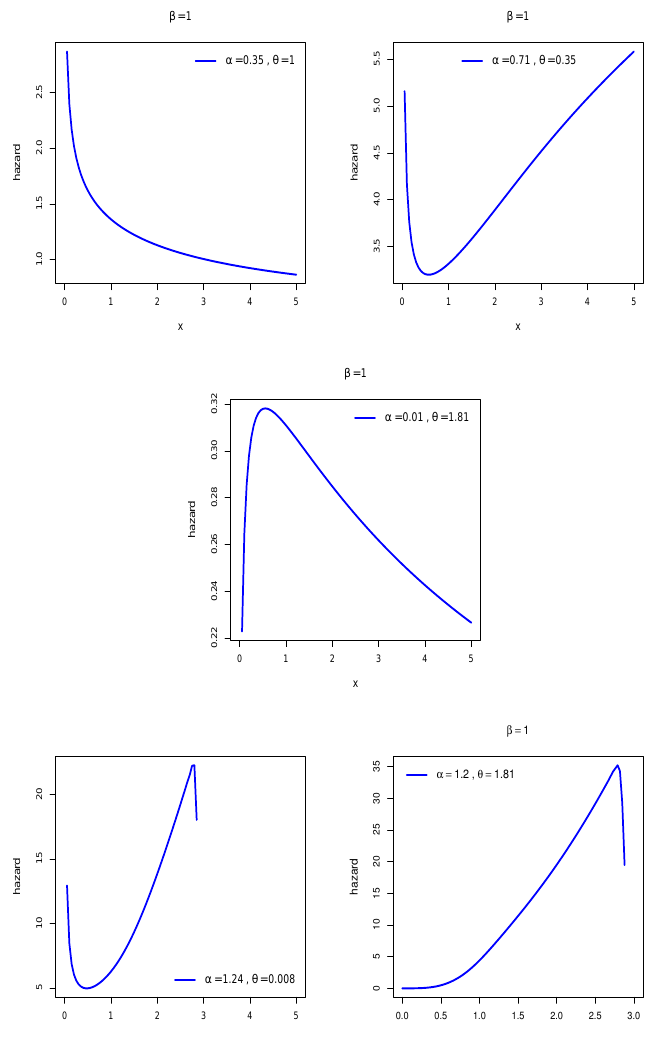
Figure 4. Plots of hrf of the SBXLL model for random parameter values.